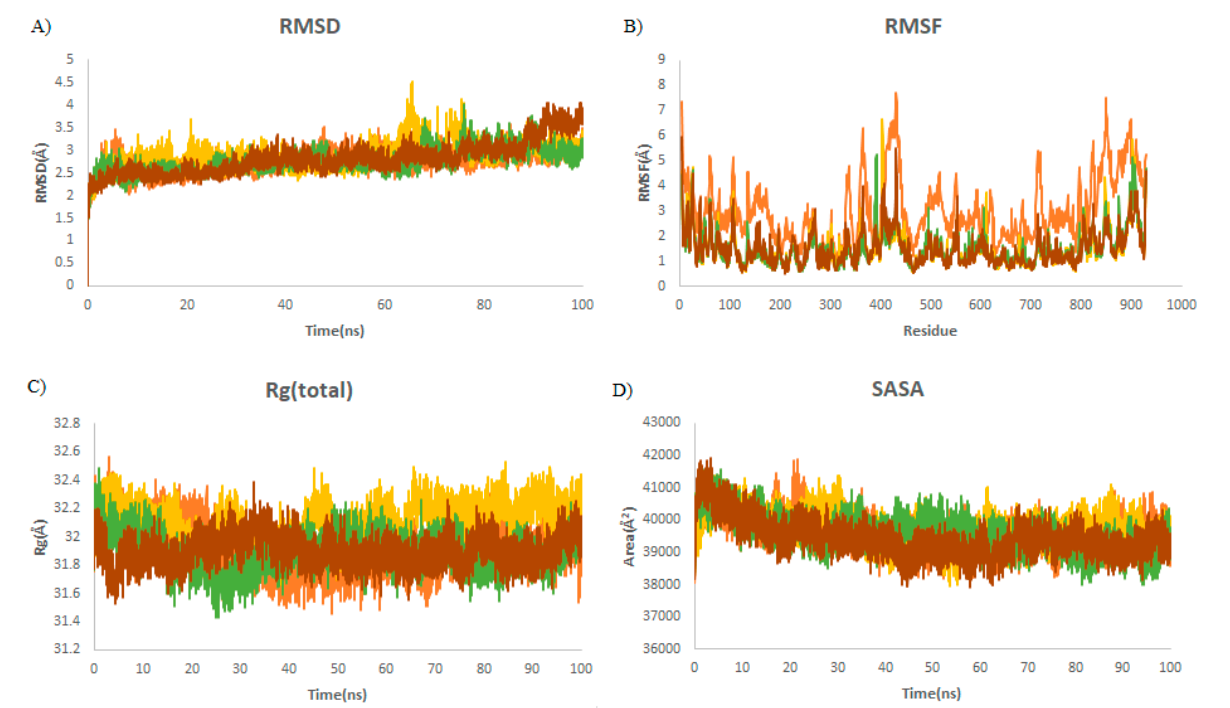
Figure 5. Structural dynamics of RdRp. ( A ) Root mean square deviation (RMSD), ( B ) root mean square fluctuations (RMSF), ( C ) radius of gyration (Rg) plot, and ( D ) solvent-accessible surface area (SASA). Orange color indicates RBD-free form; yellow, green, and brown indicate RdRp in a complex with griseofulvin, Rd6, and Rd2, respectively. Table 4. The average of RMSD, RMSF, Rg, and SASA for RdRp during the last 20 ns of MD simula-